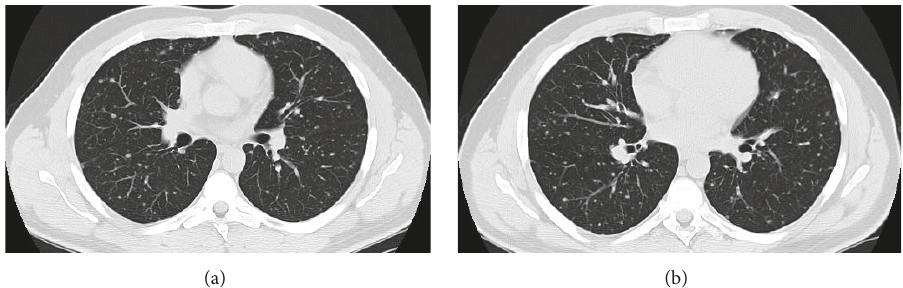
Figure 2: Chest CT (a and b). Multislice chest CT-images on lung window showed innumerable, well-defined, small, round, and noncalcified pulmonary nodular opacities, scattered in both lungs. These nodules were present in all pulmonary lobes and adjacent to bronchioles and medium/small vessels.